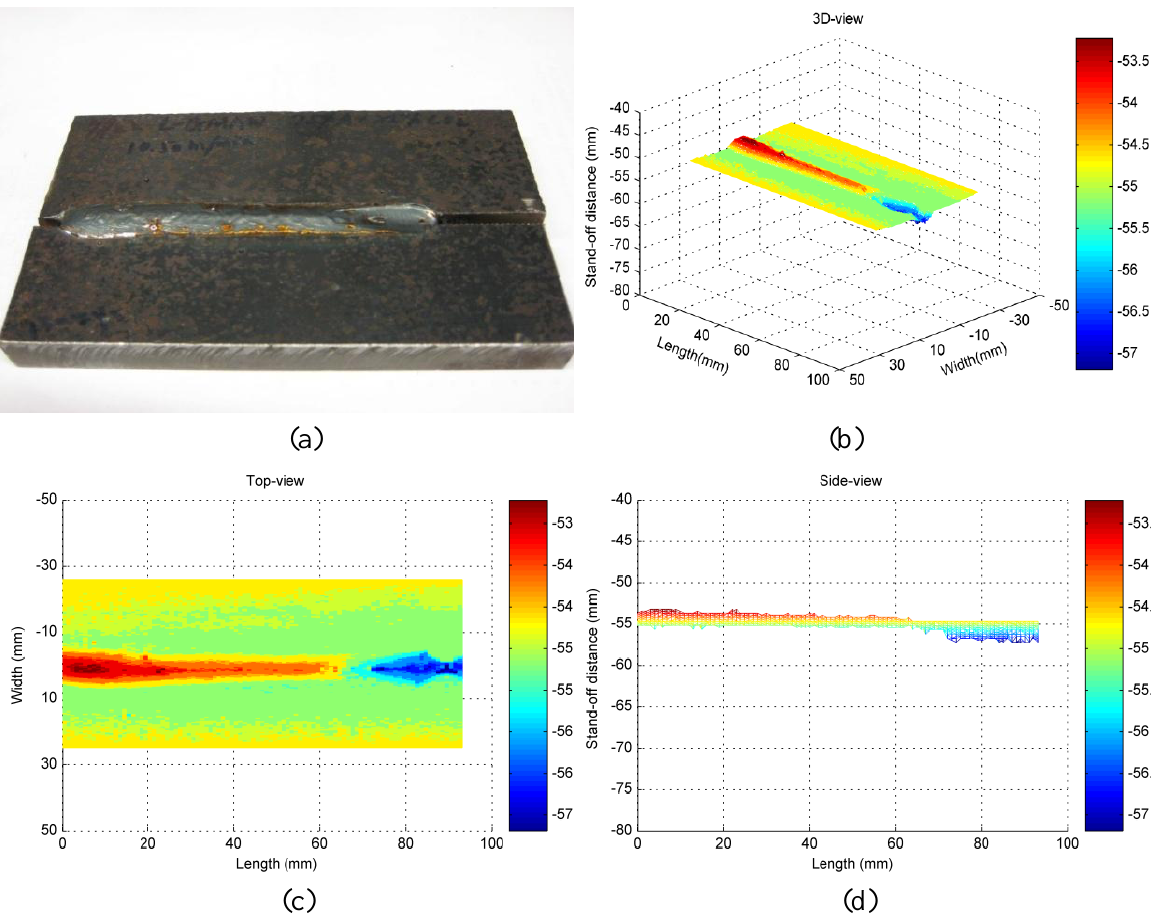
Figure 6. Results of weld quality inspection for laser-arc hybrid welding: (a) weld as the inspection target; (b) 3D-view of the inspected weld; (c) top-view of the inspected weld; (d) side-view of the inspected